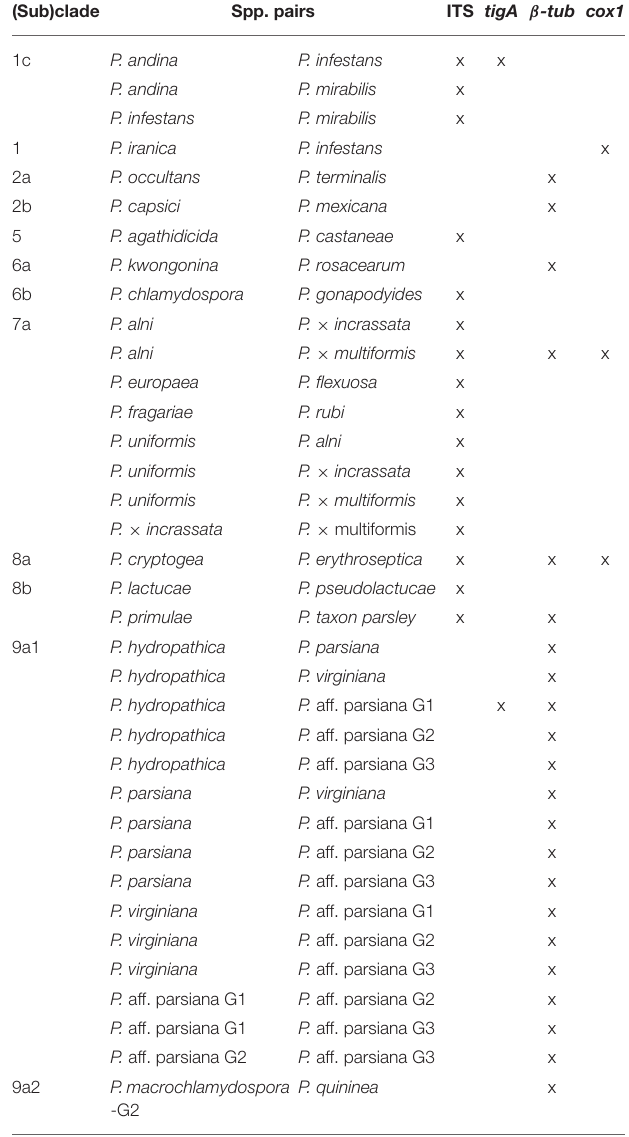
TABLE 4 | Species pairs with identical sequences for four genetic markers. (Sub)clade